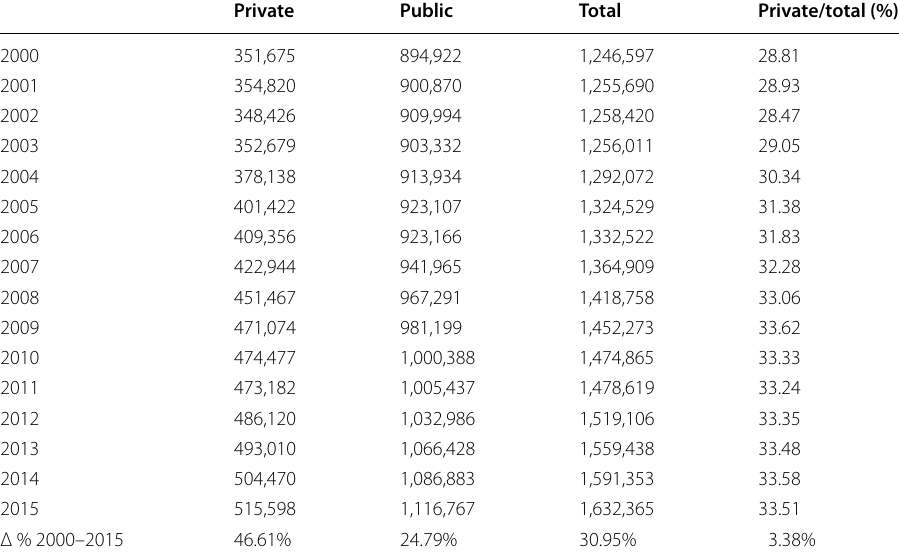
Table 1 Argentina private and public preschool (3–4 years) and kindergarten (5 years) enrollment,